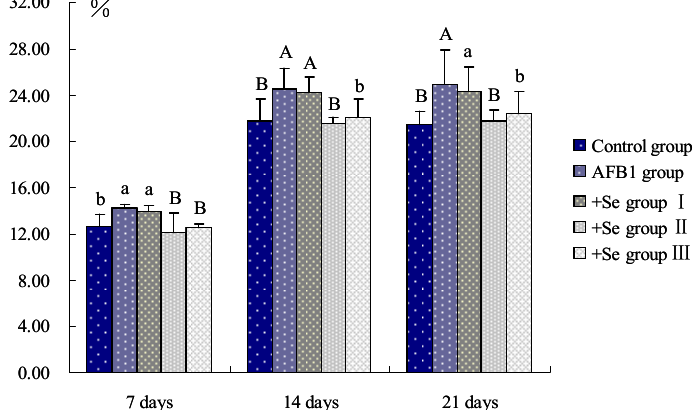
Figure 3. Effect of AFB and Se on the percentage of apoptotic splenocytes in chickens. 1